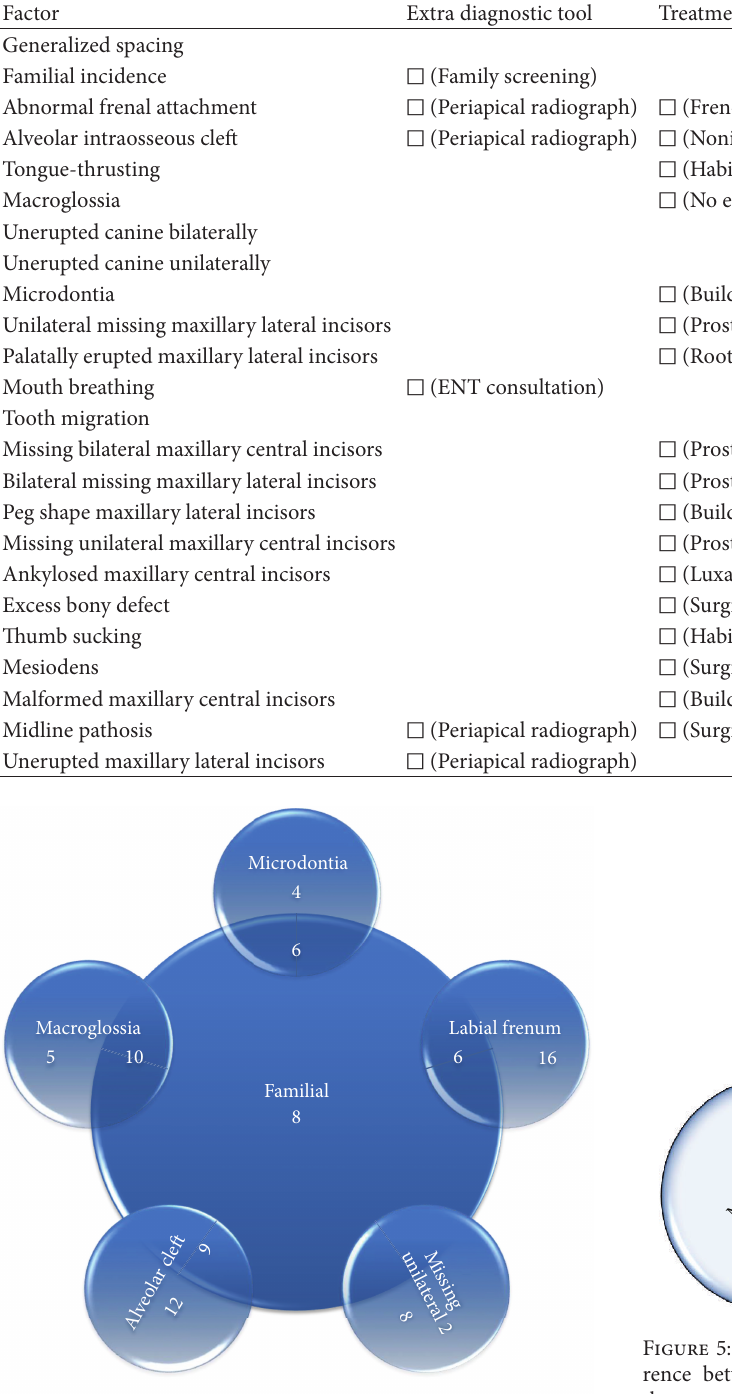
Table 2: Checklist showing the impact of each etiological factor of the maxillary midline diastema upon the diagnosis, treatment, or retention protocol.